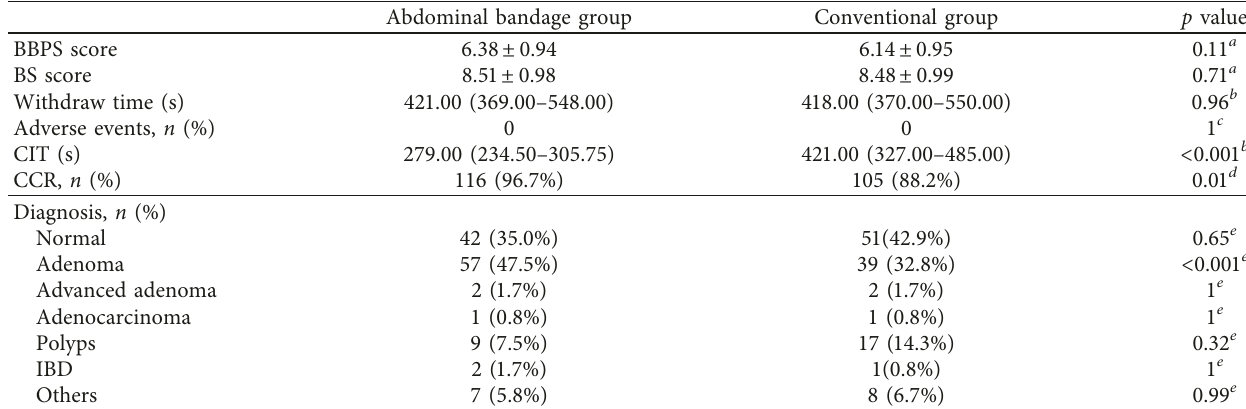
Table 2: Primary outcomes and secondary